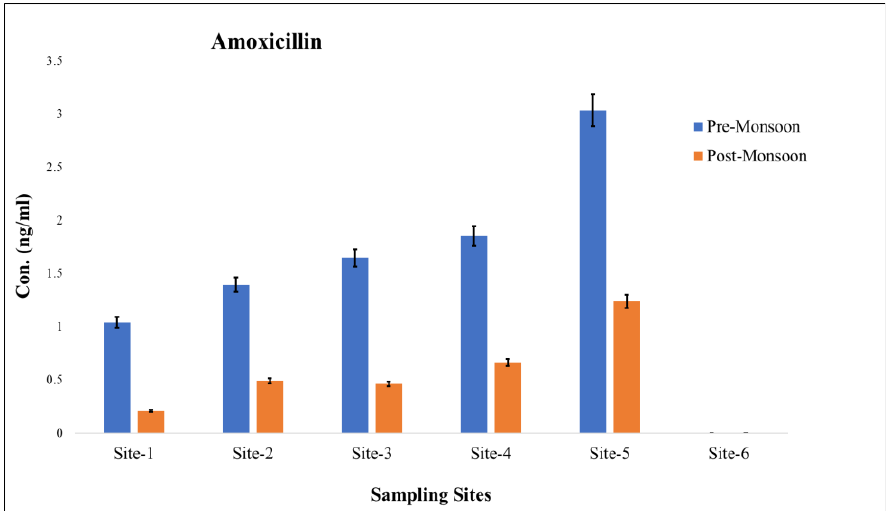
Figure 3. Amoxicillin concentration in surface water samples from various areas along the Yamuna River in Delhi, India.